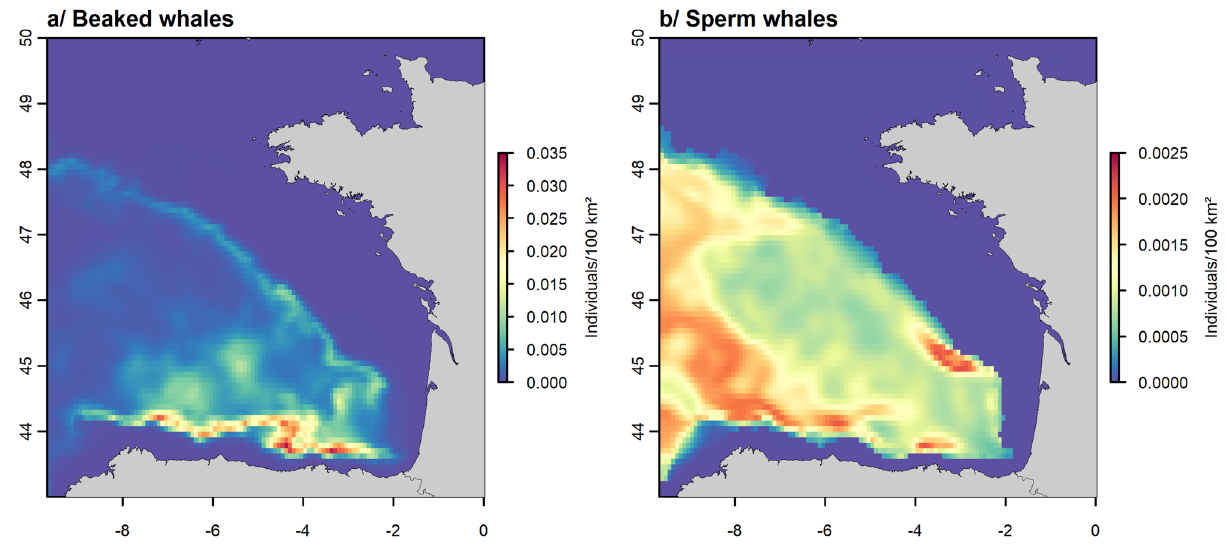
Figure 3. Predicted relative densities of beaked whales ( a ) and sperm whales ( b ) obtained from the models that use the four most important and uncorrelated